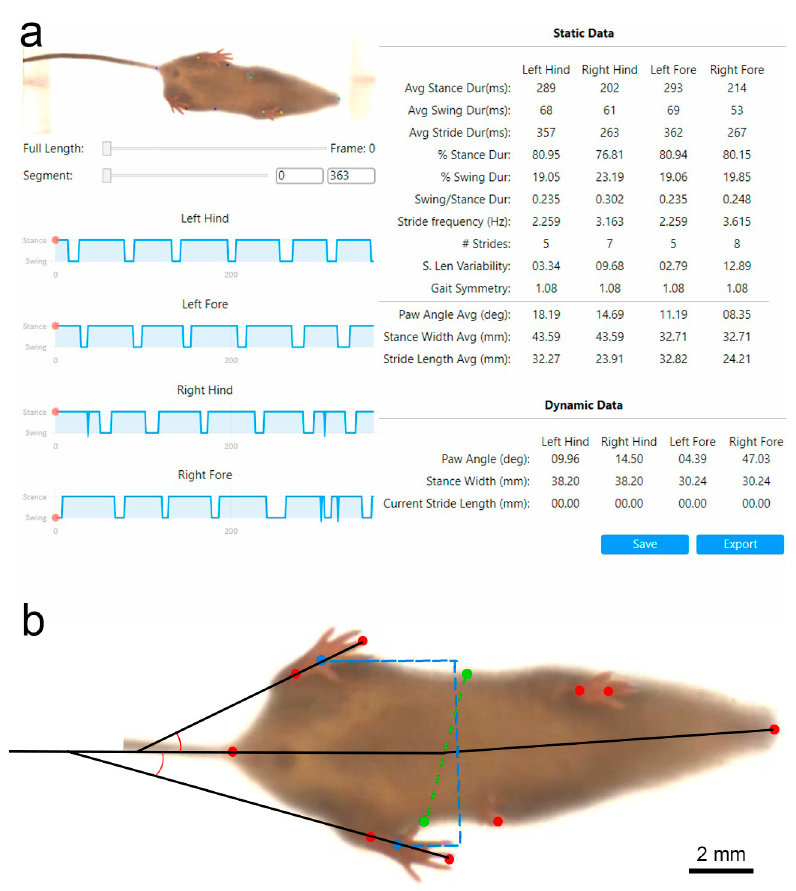
Figure 2. VGL user interface. ( a ) VGL software screenshot. Static and dynamic gait data output window for a representative animal. Software output allows the user to select both static as well as dynamic data on each labelled limb, separately or in comparison to contralateral limb and body position. ( b ) Schematic of markers and measurements of hind stance width (blue dotted line) and paw angles measured in comparison to central body axis used in software. The green dotted line represents body midpoints at abdominopelvic border. Red dots, defined by the user, correspond to body markers of nose, front and hind legs, and rear. See body text for detail . VGL, Visual Gait Lab.